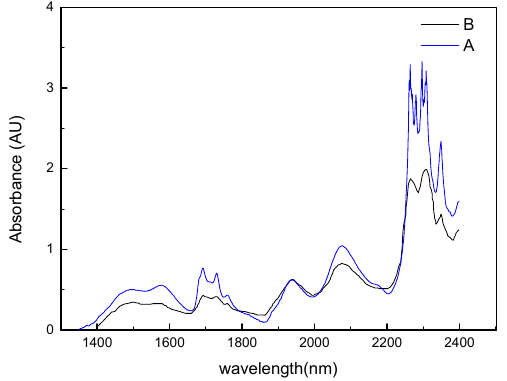
Figure 4. Absorbance spectrum of 95% ethanol. The blue line A is the reference spectrum tested by the UV-visible/NIR spectrophotometer UH4150. The black line B is the absorbance curve of the tested by the traditional scan method.